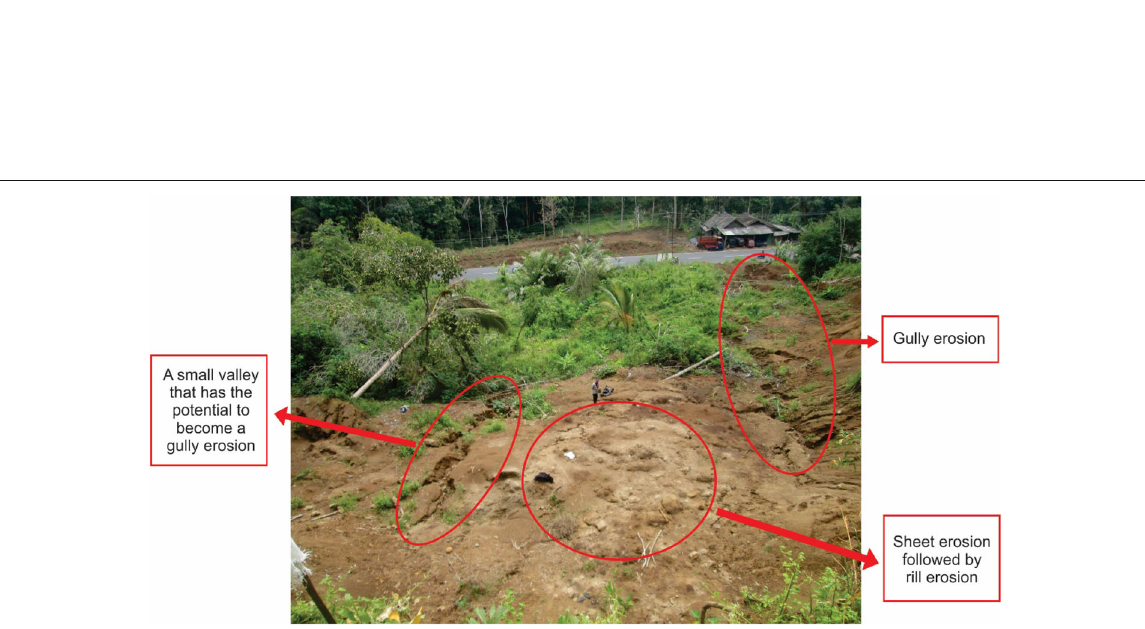
Fig. 13 The appearance of erosion in landslide